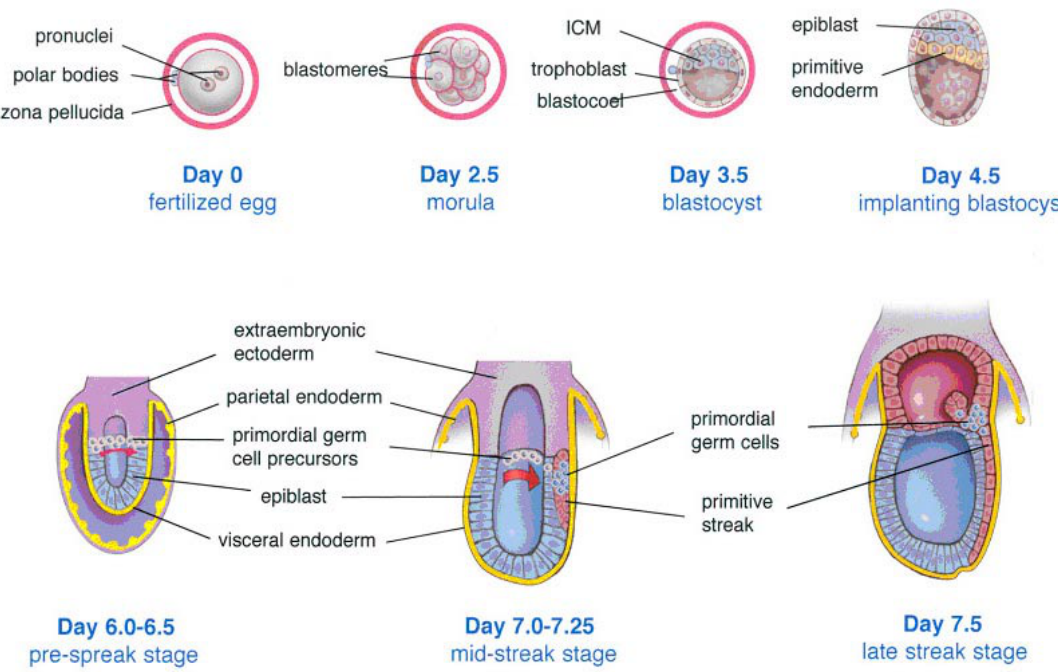
FIGURE 1. Establishment of germ cell lineage in the mouse. The developmental sequence of a mouse embryo from a fertilized egg (embryonic day 0) to gastrulation, the time of primordial germ cell formation at embryonic day 7.25(cid:150)7.5 is shown. PGC precursors localized in the proximal epiblast and definitive PGCs in the primitive streak area are depicted as pink and blue circles with darker smaller circles as nuclei, respectively. PGC precursors migrate posteriorly into primitive streak and segregate into PGCs and mesoderm (red